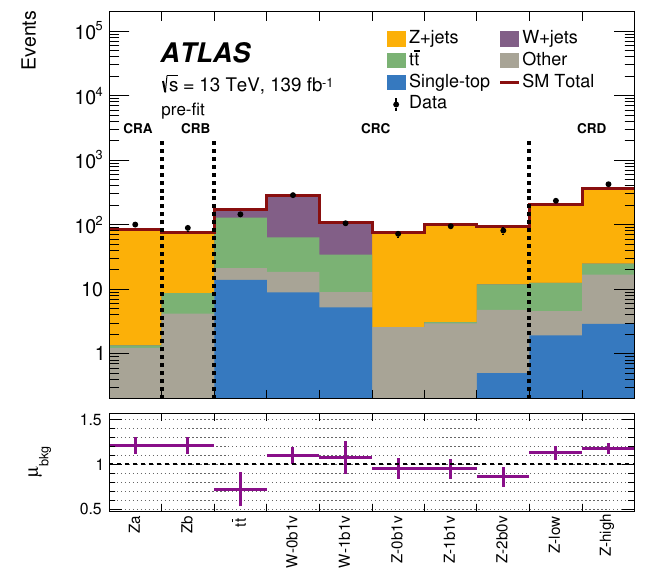
Figure 3 . Comparison between observed and pre-fit predicted background yields for the con- trol regions. In the ratio plot, µ represents the value (with uncertainty) of the free-floating bkg normalisation parameter for the dominant background process in each region obtained with the background-only fit. The “Other” category includes contributions from diboson and t ¯ t + W/Z/H